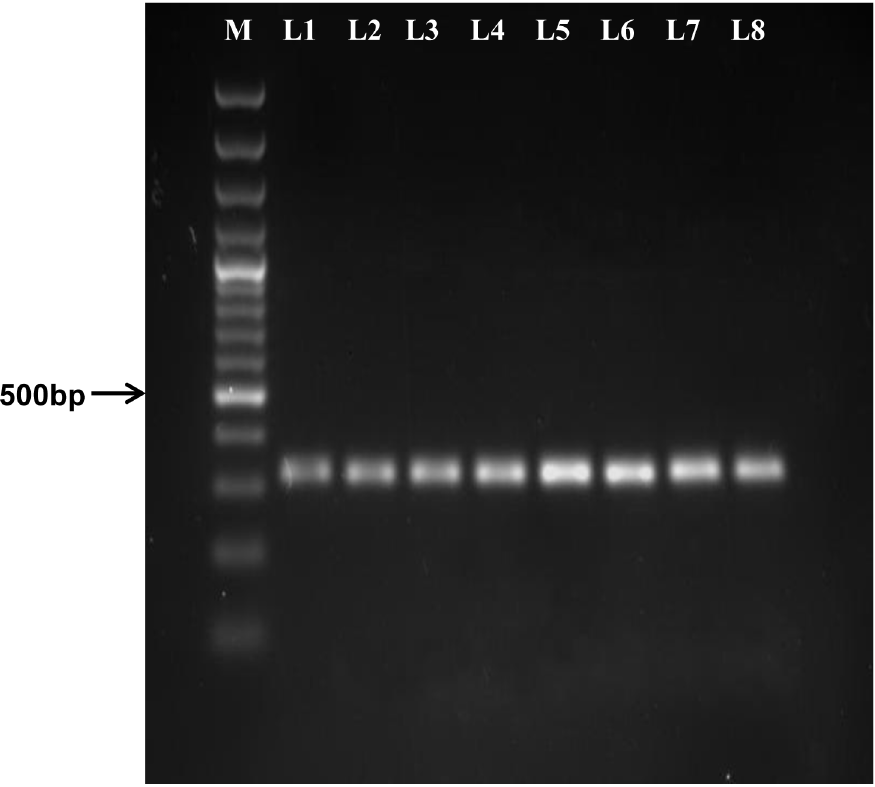
Figure 5. Agarose gel image of the amplified Blastocystissp heat shock protein (HSP) 70 gene. The amplicon size of the target region is 318 bp. Lane M=DNA markers of 100 bp plus DNA ladder (Fermentas, USA); lane 1–4= subtype 1; lane 5–7= subtype 3 and lane 8= subtype 5.